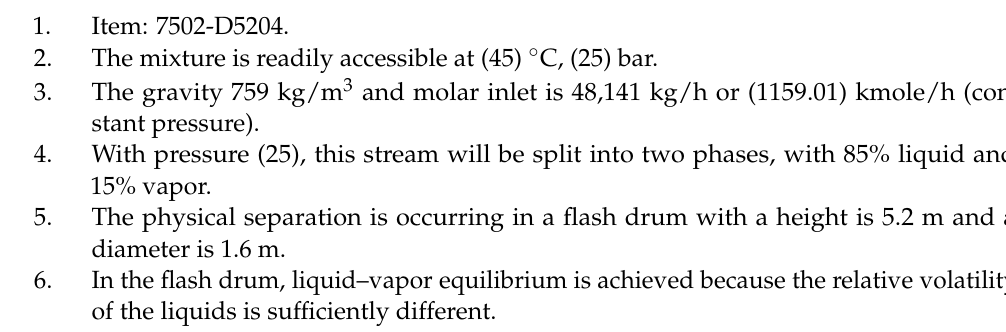
Figure 3. D5204 in Basrah Refinery: ( a ) process tank; ( b ) electrival